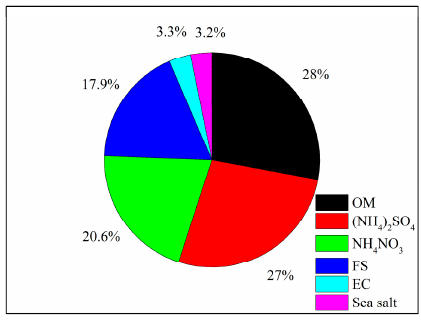
Figure 4. Mass contributions of different components to the total PM 2.5 mass.